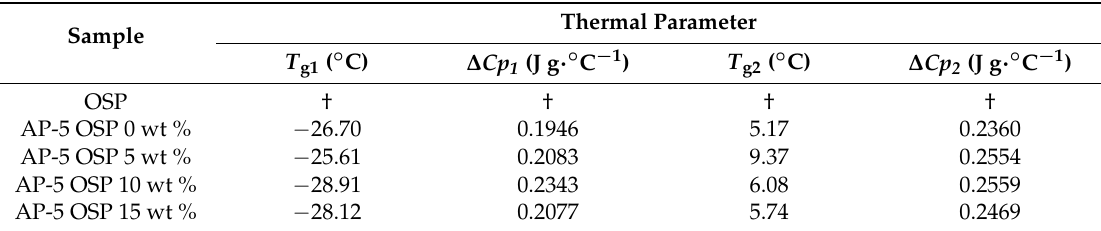
Table 6. DSC thermogram data of OSP, neat asphalt, and OSP/asphalt blends containing 5, 10,